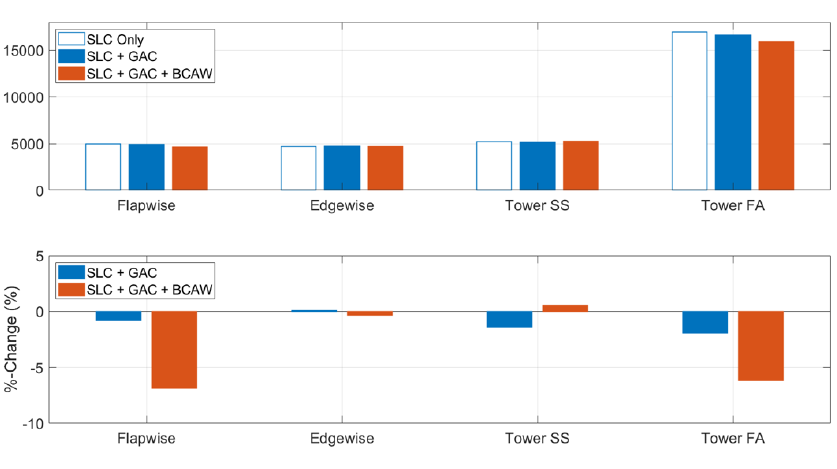
Figure 13. Variation of the DELs of the blade root and tower base bending moments under normal turbulence wind with different control architectures. Top—Dimensional DELs; Bottom—Percentage changes with respect to ‘SLC Only’